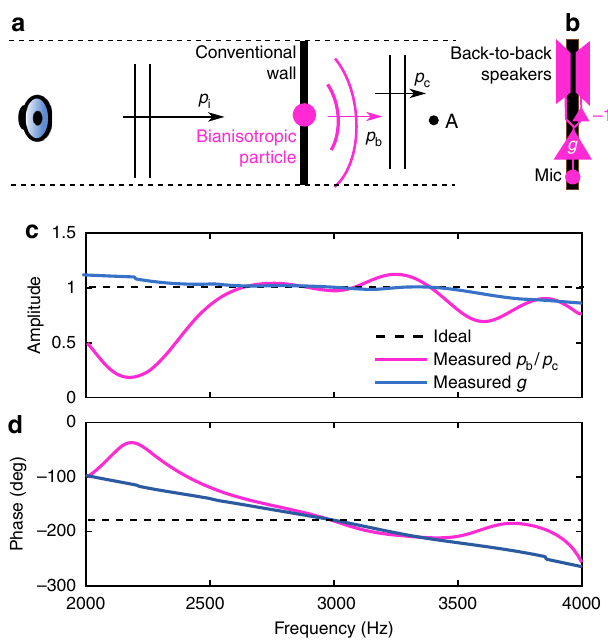
Fig. 2 Bianisotropic meta-atom design. a A bianisotropic meta-atom is embedded in a conventional wall. An incident wave p i produced by an external speaker propagates through the conventional wall. The bianisotropic . d response of the particle, p b , and the transmission though the wall, p c are recorded at point A situated 2cm behind the particle. b The bianisotropic meta-atom is composed of monopole and dipole transducers connected through the ampli fi er of impulse response g . The dipole driver is implemented as two back-to-back speakers driven 180° out-of-phase and generates pressure fi elds of inverse polarity in the two semi-planes separated by the dipole ’ s anti-symmetry plane. The monopole sensor is placed in the antisymmetry plane of the dipole source and senses zero net pressure generated by the dipole. c , Amplitude of p b / p c measured on the meta-atom transmission side 1cm behind the meta-atom versus measured amplitude of ampli fi er impulse response g . d , Measured phases of p b / p c and